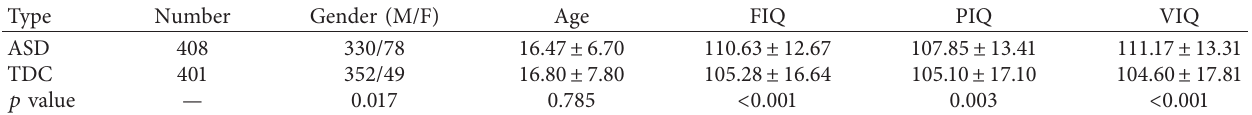
Table 1: Demographic information of 809 subjects from